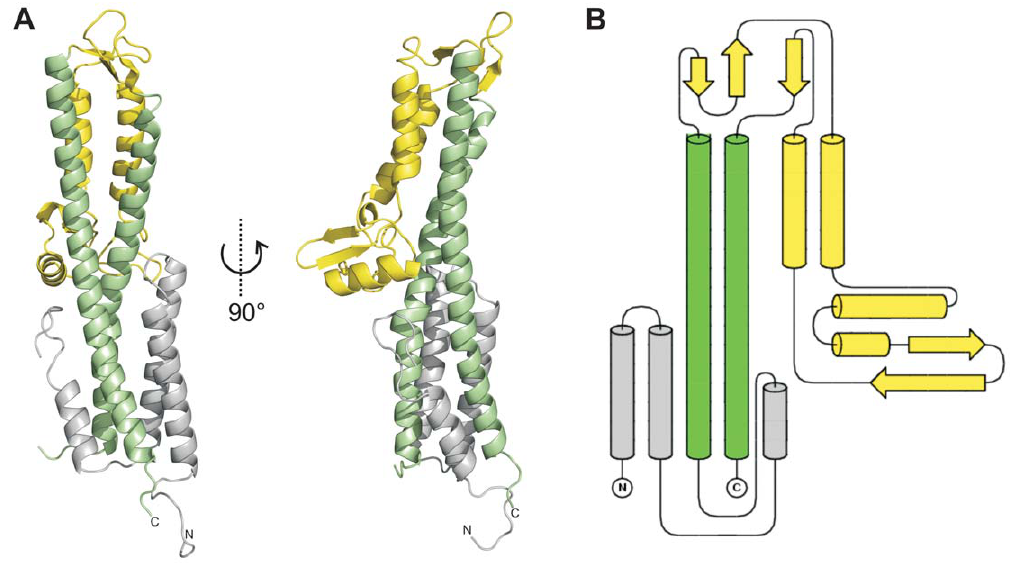
Figure 1. Crystal structure of SipD. (A) X-ray crystal structure and (B) topology plot of SipD chain A from S. typhimurium : structurally distinguishable domains are coloured in grey (domain 1), green (domain 2), and yellow (domain 3), respectively.